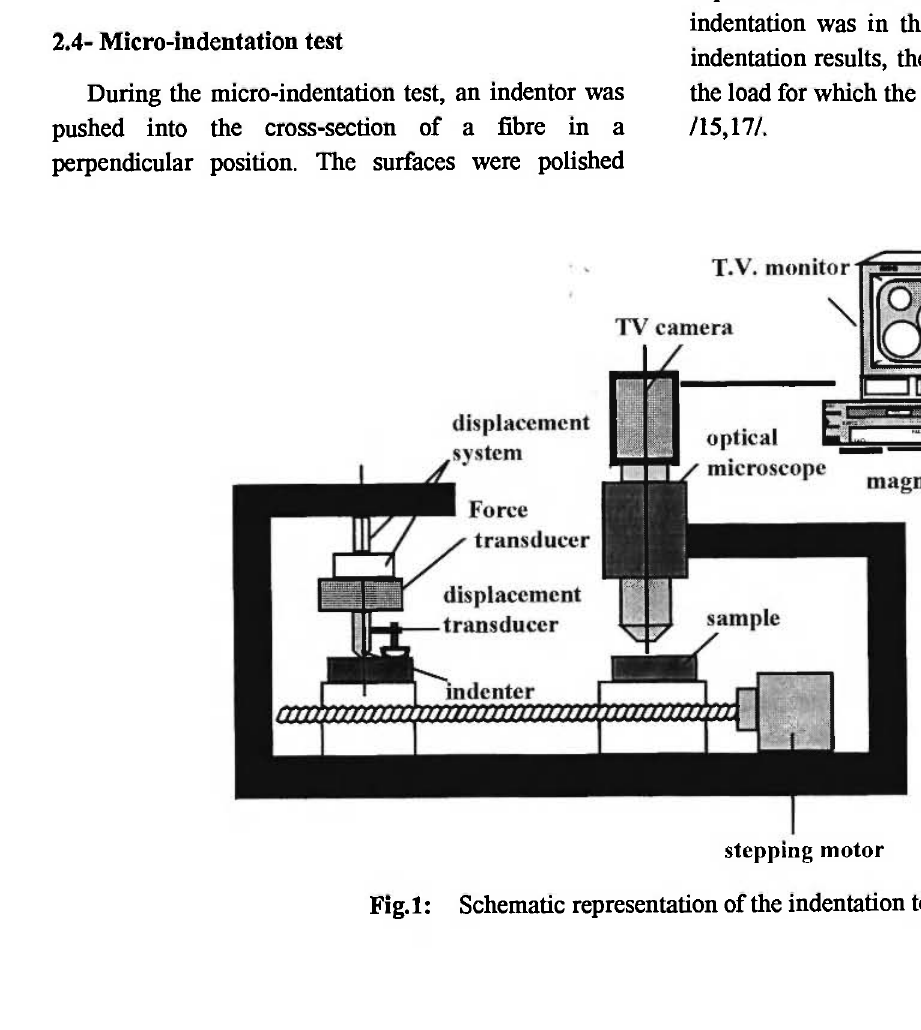
Fig. 1: Schematic representation of the indentation